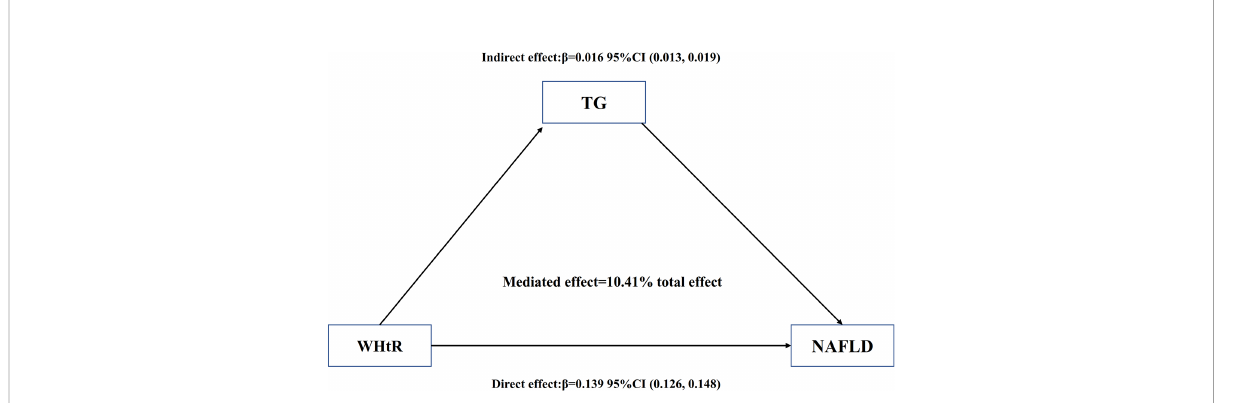
FIGURE 6 Mediation of TG on the association between WHtR and NAFLD. Figure 6 indicated that WHtR had a signi fi cant direct effect on NAFLD( b =0.139, 95% CI: 0.126, 0.148), and TG partly mediated the indirect effect of WHtR on NAFLD( b =0.016, 95% CI: 0.013-0.019). Therefore, approximately 10.41% of the WHtR effect on NAFLD was mediated through TG levels. Zero was not included in 95% con fi dence intervals representing statistical signi fi cance.